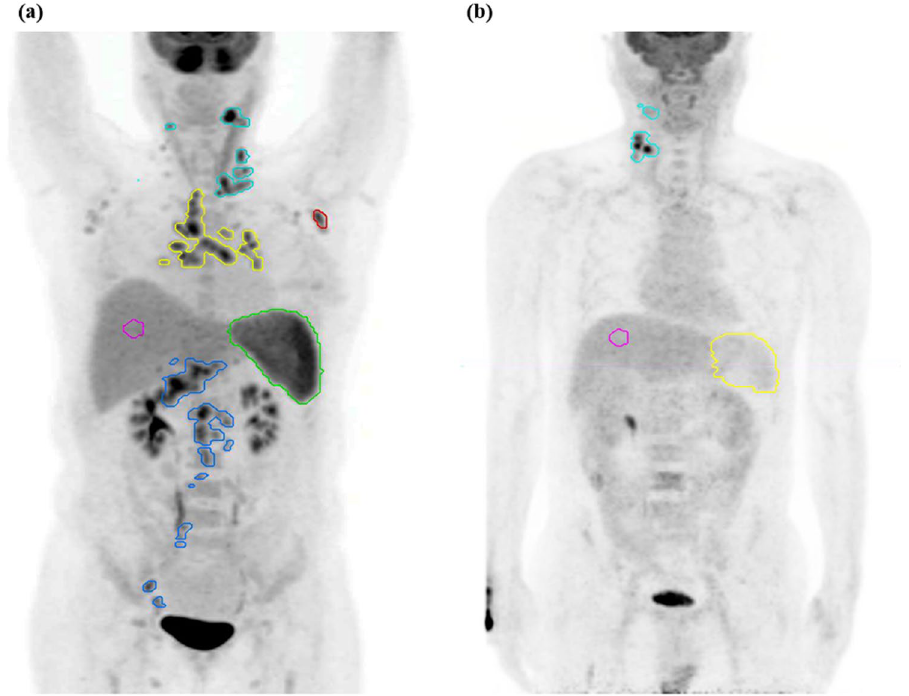
Figure 1. Maximum intensity projection images of representative mild and severe Kikuchi-Fujimoto disease patients with lesion segmentation. ( a ) A patient with severe Kikuchi-Fujimoto disease. Systemic increase in 18 F- FDG uptake in the spleen and lymph nodes is seen. ( b ) A patient with mild Kikuchi-Fujimoto disease. Lesser FDG-avid lymph nodes are